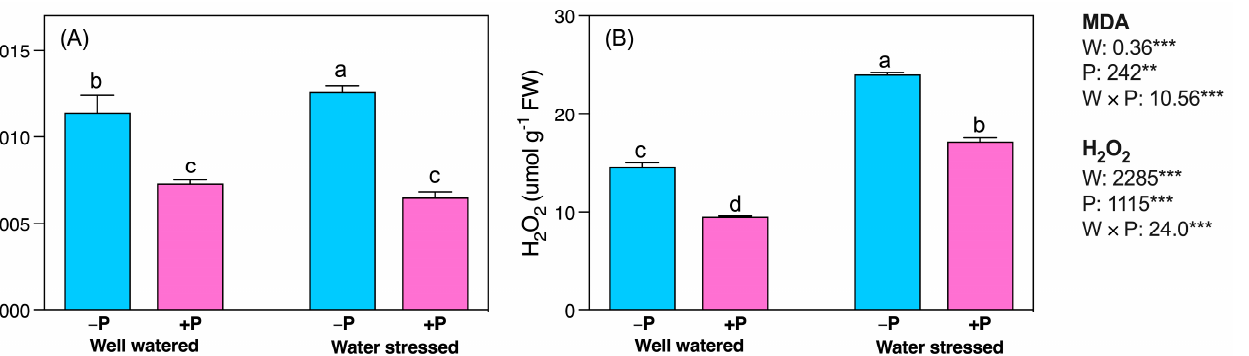
Figure 5. Changes in concentrations of ( A ) MDA and ( B ) H 2 O 2 in response to P supplementation, under well-watered and drought-stressed conditions. A different letter following the means indicates significant differences ( p < 0.05) between the four treatments, as determined by Duncan’s test. Bars represent means ± SD. An overview of the two-way ANOVA assessing the effect of water (W) and phosphorus (P) treatments is presented in the right-hand corner of each panel. ** and *** indicate that F values were significant at p ≤ 0.05, 0.01, and 0.001, respectively.